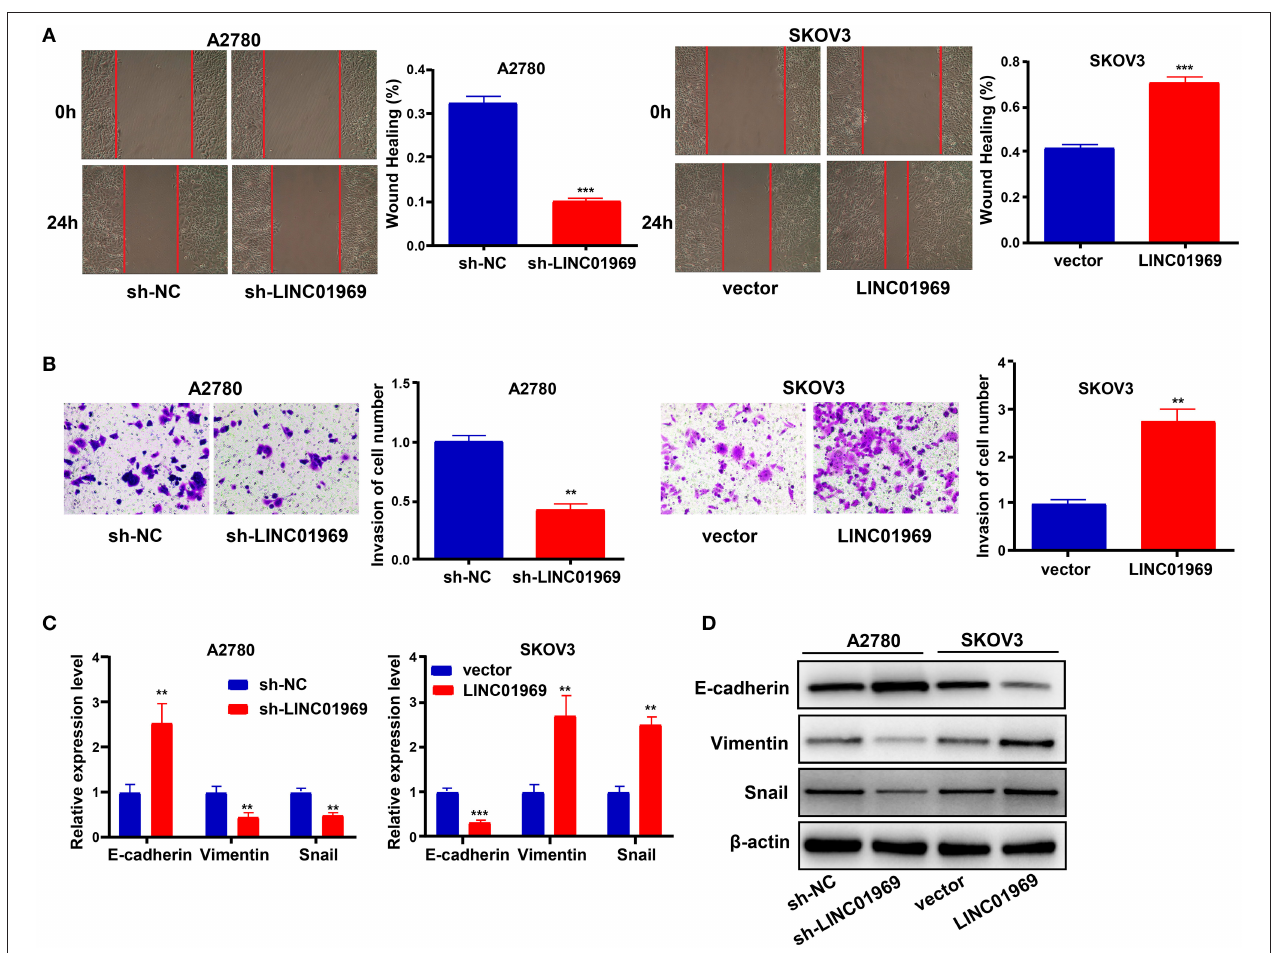
FIGURE 4 | LINC01969 promotes the cell migration, invasion, and epithelial–mesenchymal transition (EMT) of ovarian cancer (OC) cells. (A) Wound healing assay showed that LINC01969 silencing suppressed the ability of OC cell migration. (B) Transwell assay showed that LINC01969 silencing suppressed the ability of OC cell invasion. (C,D) The expression of EMT markers were determined using quantitative real-time PCR (qRT-PCR) and Western blot assay. Data were presented as mean ± SD of three independent experiments; ** P < 0.01, *** P <